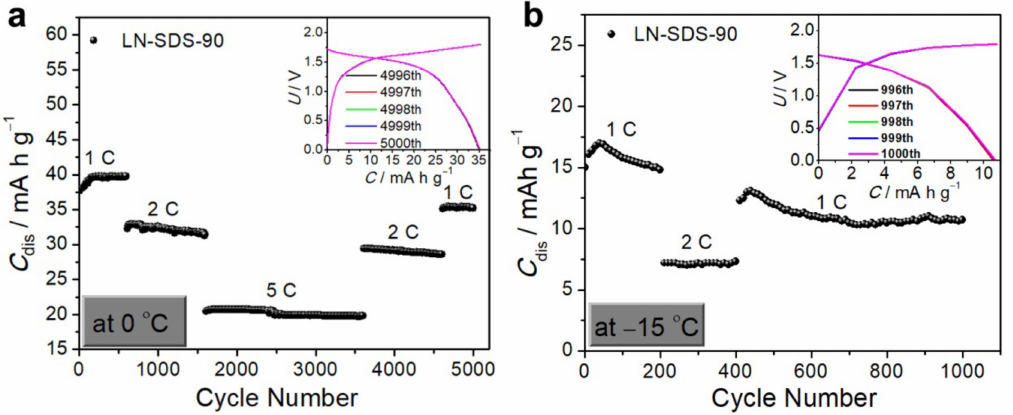
Figure 6. Electrochemical performance of NTP (cid:107) LMO operating with LN-SDS-90 at: ( a ) 0 ◦ C and ( b ) − 15 ◦ C. Insets in ( a ) and ( b ) are the GCD curves of the final five